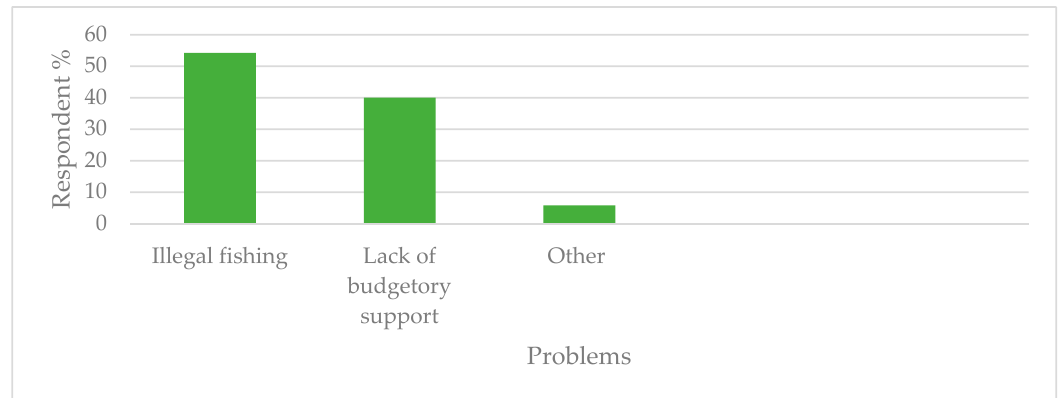
Figure 2. Major problems in community fish refuges (CFRs) management.